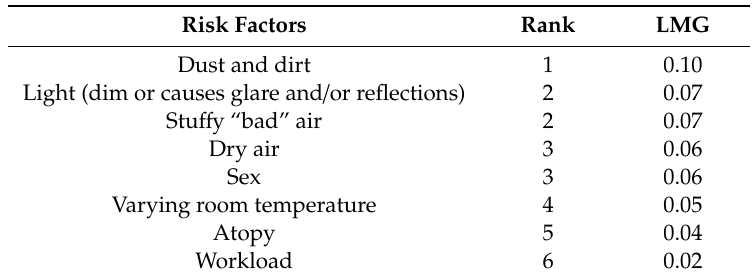
Table 5. Estimates for impact level in each dependent